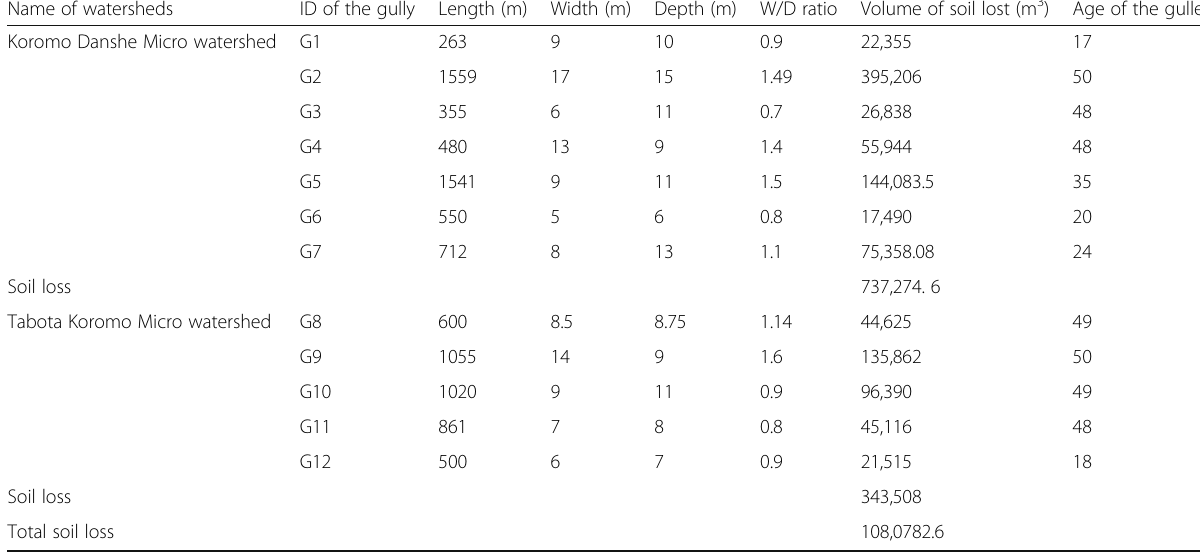
Table 7 Field measurement result on gully erosion Name of